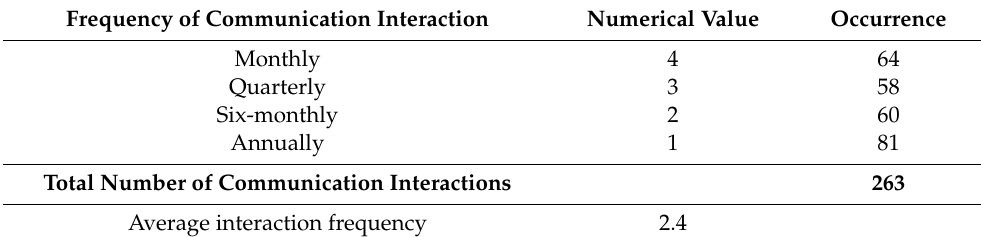
Table 6. Frequency of communication interaction between WEF-Nexus